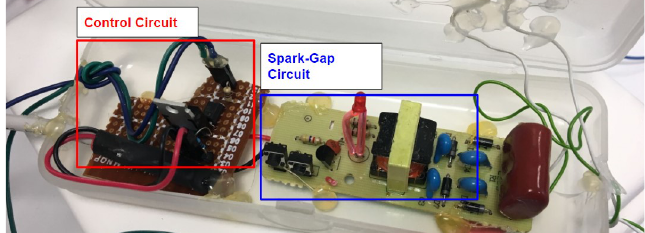
Figure 2. The EM fault injector. Both circuits are placed inside of the plastic case and the spark gap can be seen glued to the top of the case. The wires to the left and the right are for the control and the spark gap circuit,